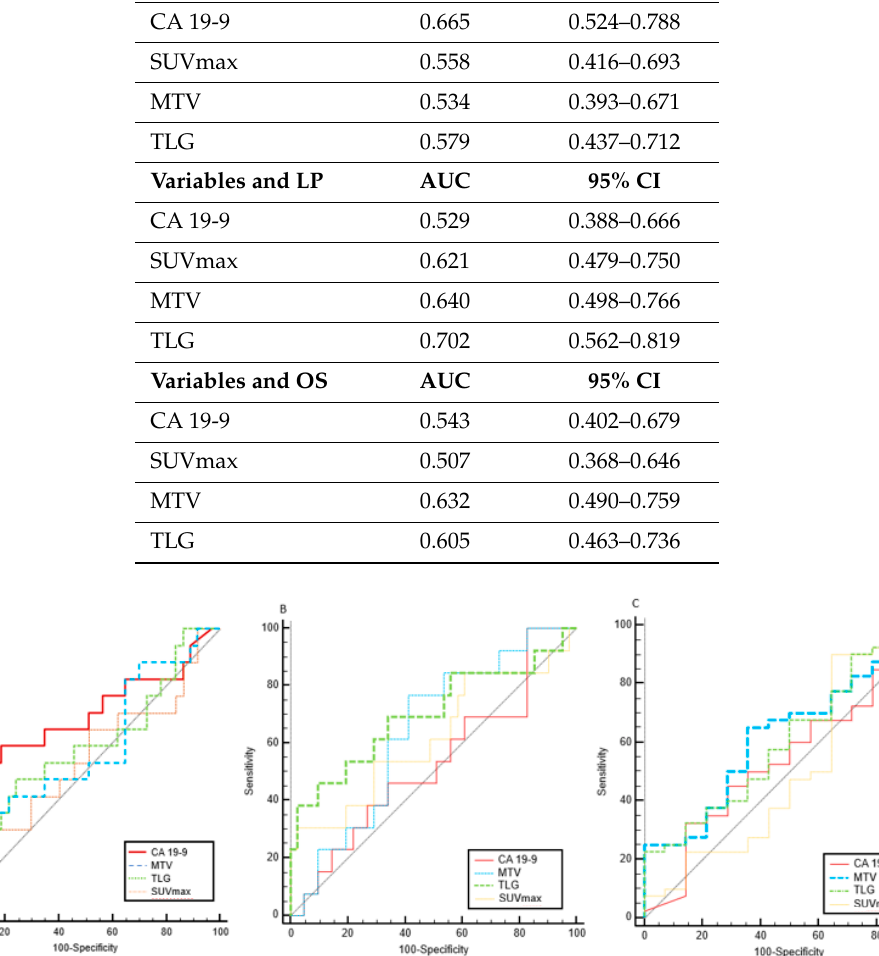
Table 3. Predictors of Early Progression (EP). The variables analyzed were CA 19-9, the maximum standardized uptake value (SUVmax), the metabolic tumour volume (MTV), the total lesion glycolysis (TLG) of primary tumours. LR+, likelihood-ratio positive; PPV, Positive Predictive Value.